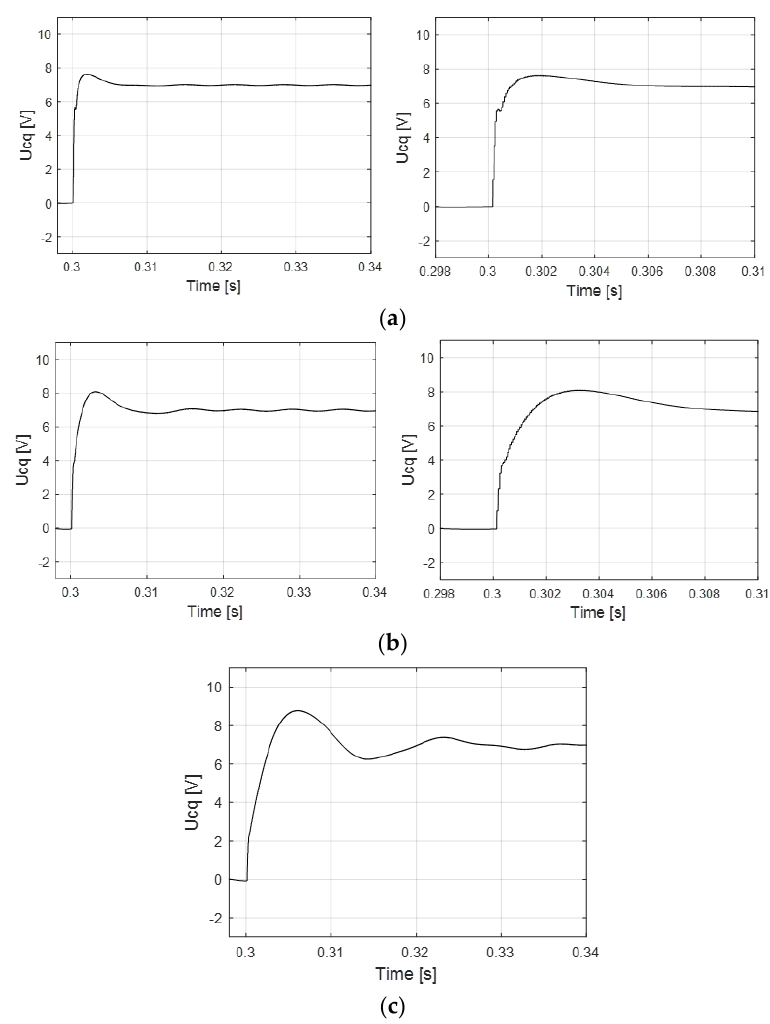
Figure 23. Step response of capacitor voltage u cq : ( a ) set 1: r c = 2.5 Ω, K vp = 0.2, f z = 700 Hz; ( b ) set 2: r c = 2.5 Ω, K vp = 0.15, f z = 400 Hz; ( c ) set 3: r c = 2.5 Ω, K vp = 0.1, f z = 200 Hz .